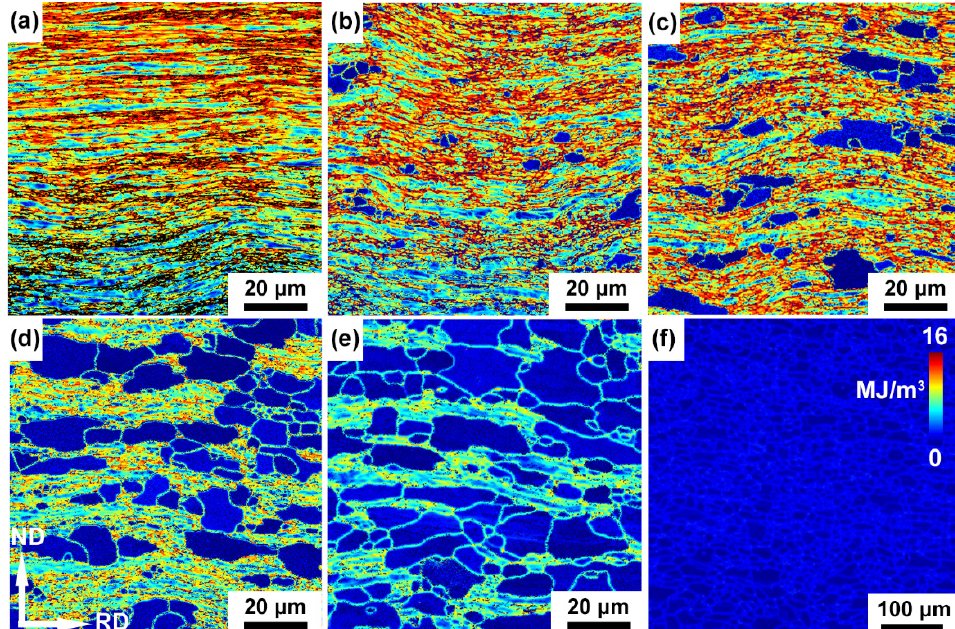
Figure 8. Stored energy maps of the cold-rolled IF steel annealed at 600 ° C for ( a ) 0 h, ( b ) 4 h, ( c ) 8 h, ( d ) 16 h, ( e ) 32 h and ( f ) 64 h.